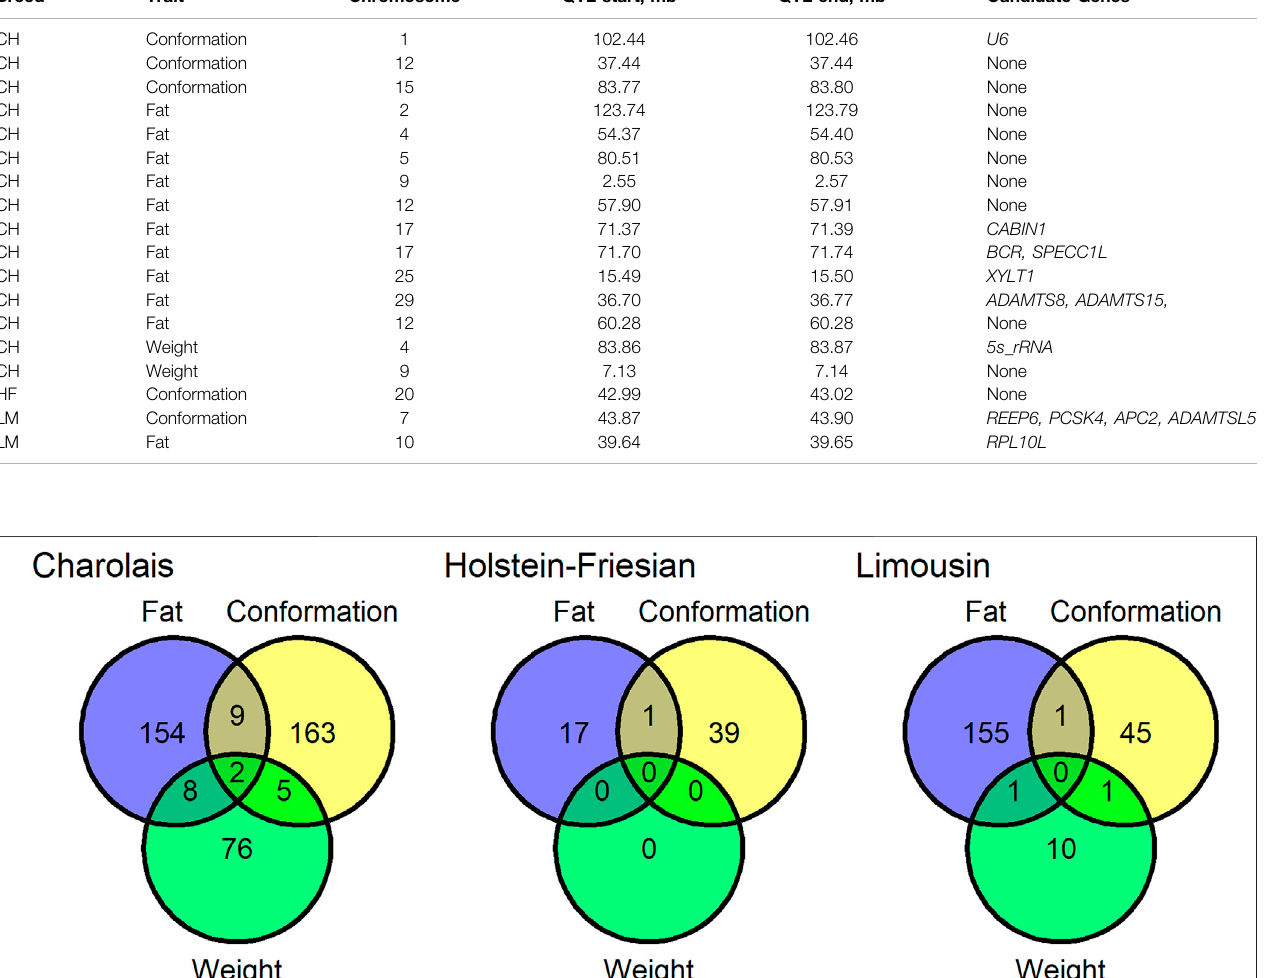
TABLE 2 | Chromosome, position, and candidate gene(s) for each copy number variant (CNV) quantitative trait locus (QTL) associated with each of the carcass traits in Charolais (CH), Holstein-Friesian (HF), and Limousin (LM). When no genes overlapped the QTL region none is reported in the candidate gene column. Breed